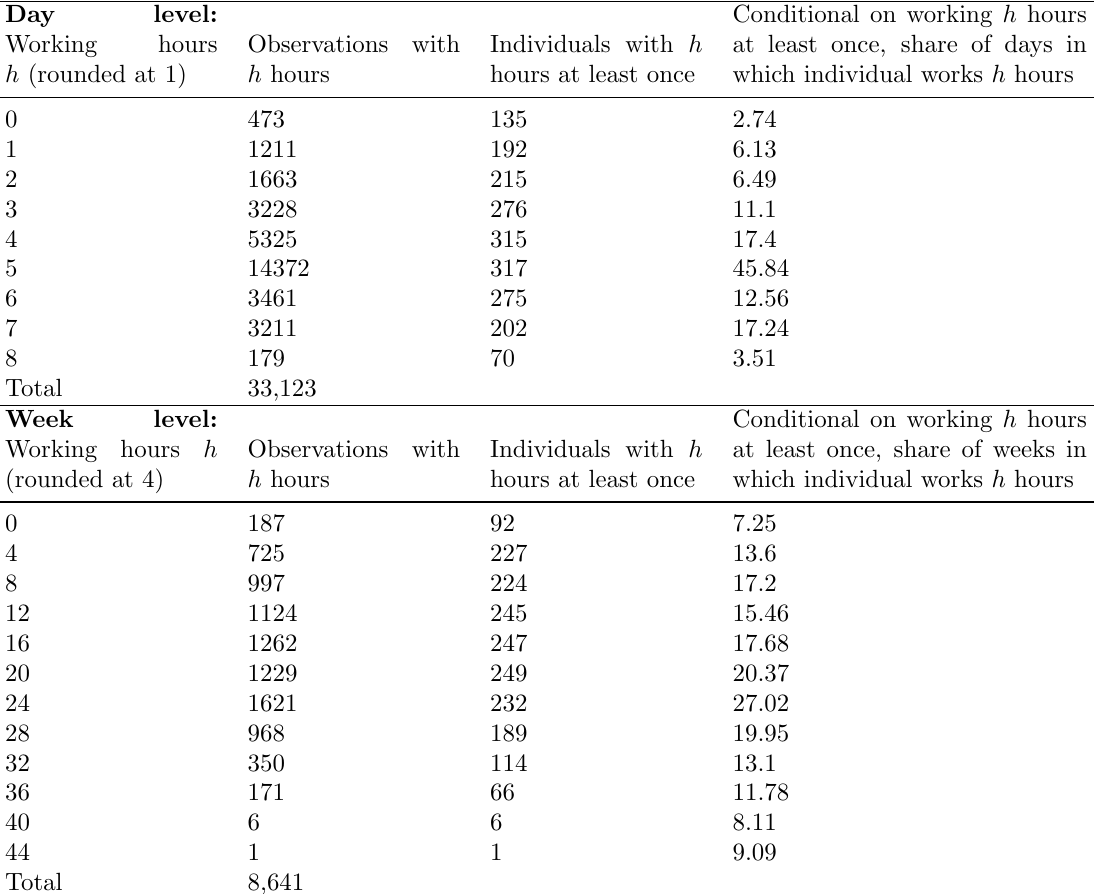
Table 2: Variation in daily and weekly working